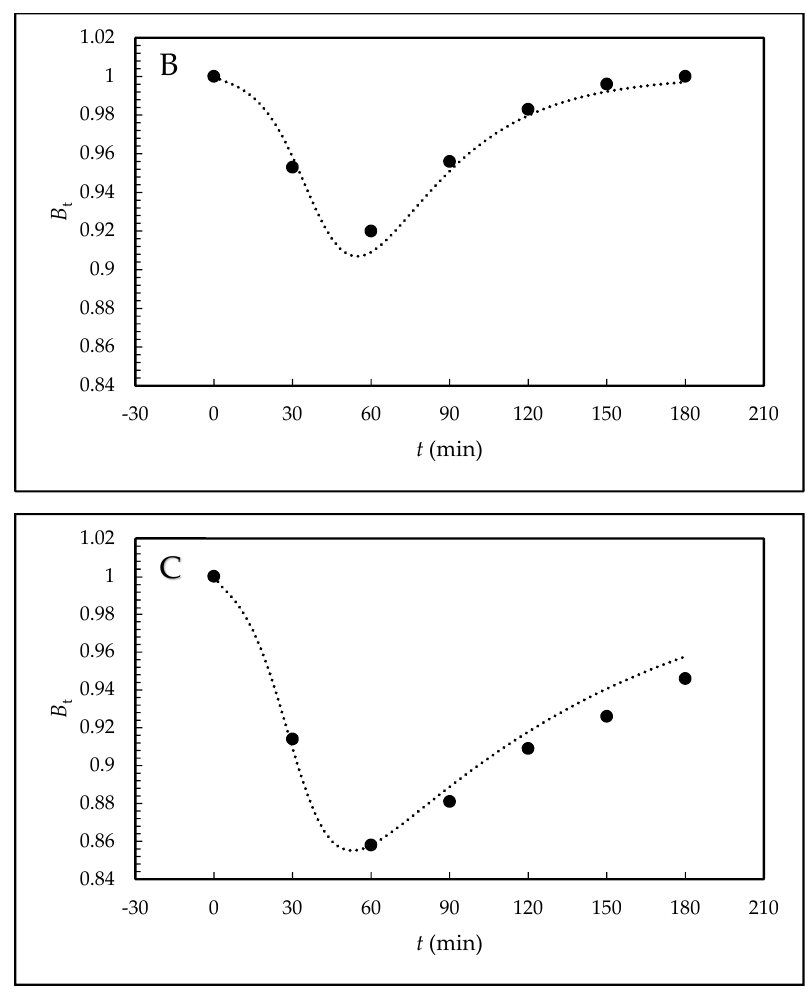
Figure 3. Theoretical shape of the B ( t ) curves obtained by integration of the kinetic equations for the selected concentrations ( A ) 200 µ g / L, ( B ) 20 µ g / L, and ( C ) 2 µ g / L, molar ratios n , and optimized values of K 1 – K 5 (see Table 3) with designation of the B t points obtained in the experiment (see Table